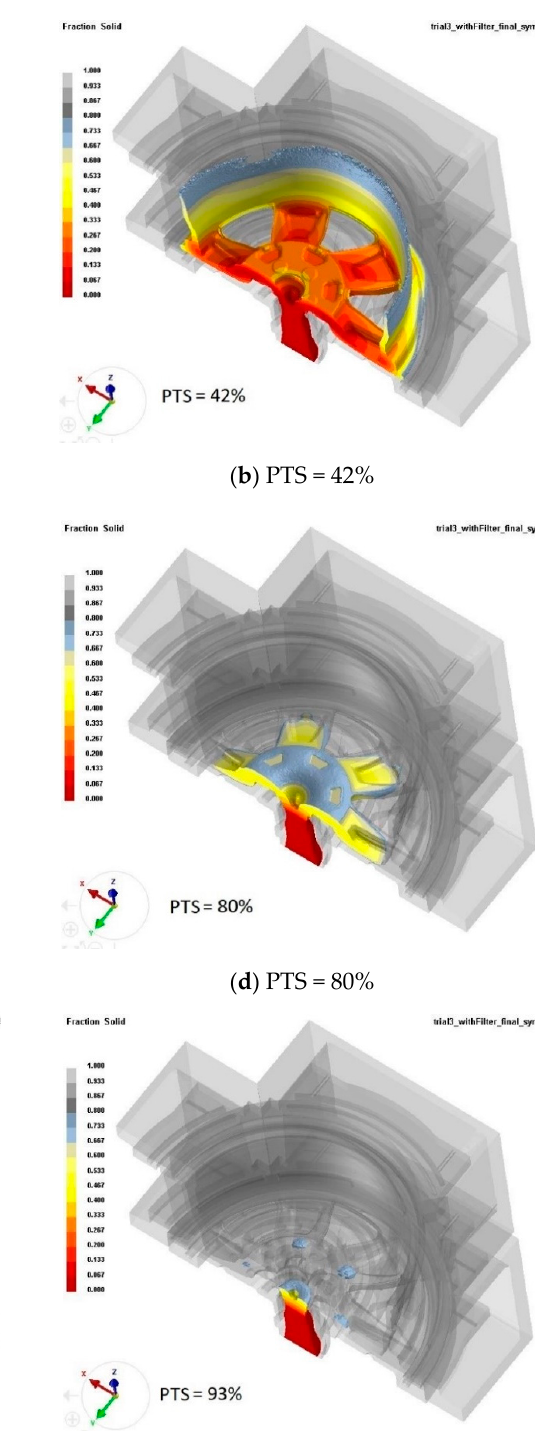
Figure 17. Geometric features of the bottom die for producing the bolt holes in the wheel in Die-A. Turning to the non-production process condition, only the stages with the formation of liquid encapsulation are presented in Figure 18 for brevity. It can be seen that liquid encapsulation formed in two regions: the rim/spoke junction at PTS = 85%, and the spoke/hub junction at PTS = 94%. The former is ~27 mm in equivalent radius, whereas the latter has a similar location and size (~16 mm in equivalent radius) to that predicted in the production process condition wheel. Compared to the X- ray radiography results [17], Figure 19, with the larger area of liquid encapsulation predicted by the model, indicates consistency. This lends some support to the conclusion that the other smaller areas of liquid encapsulation yielded porosities below the detection limit.